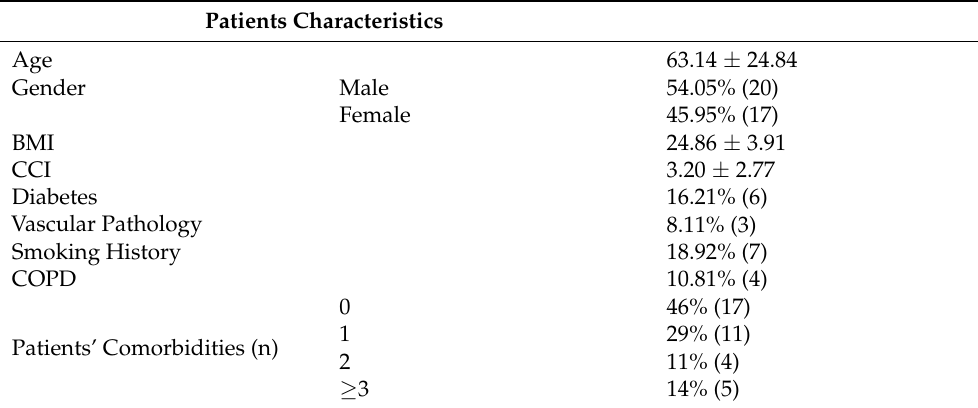
Table 1. Patients’ characteristics. BMI: Body Mass Index; CCI: Charlson Comorbidity Index; COPD: chronic obstructive pulmonary disease.